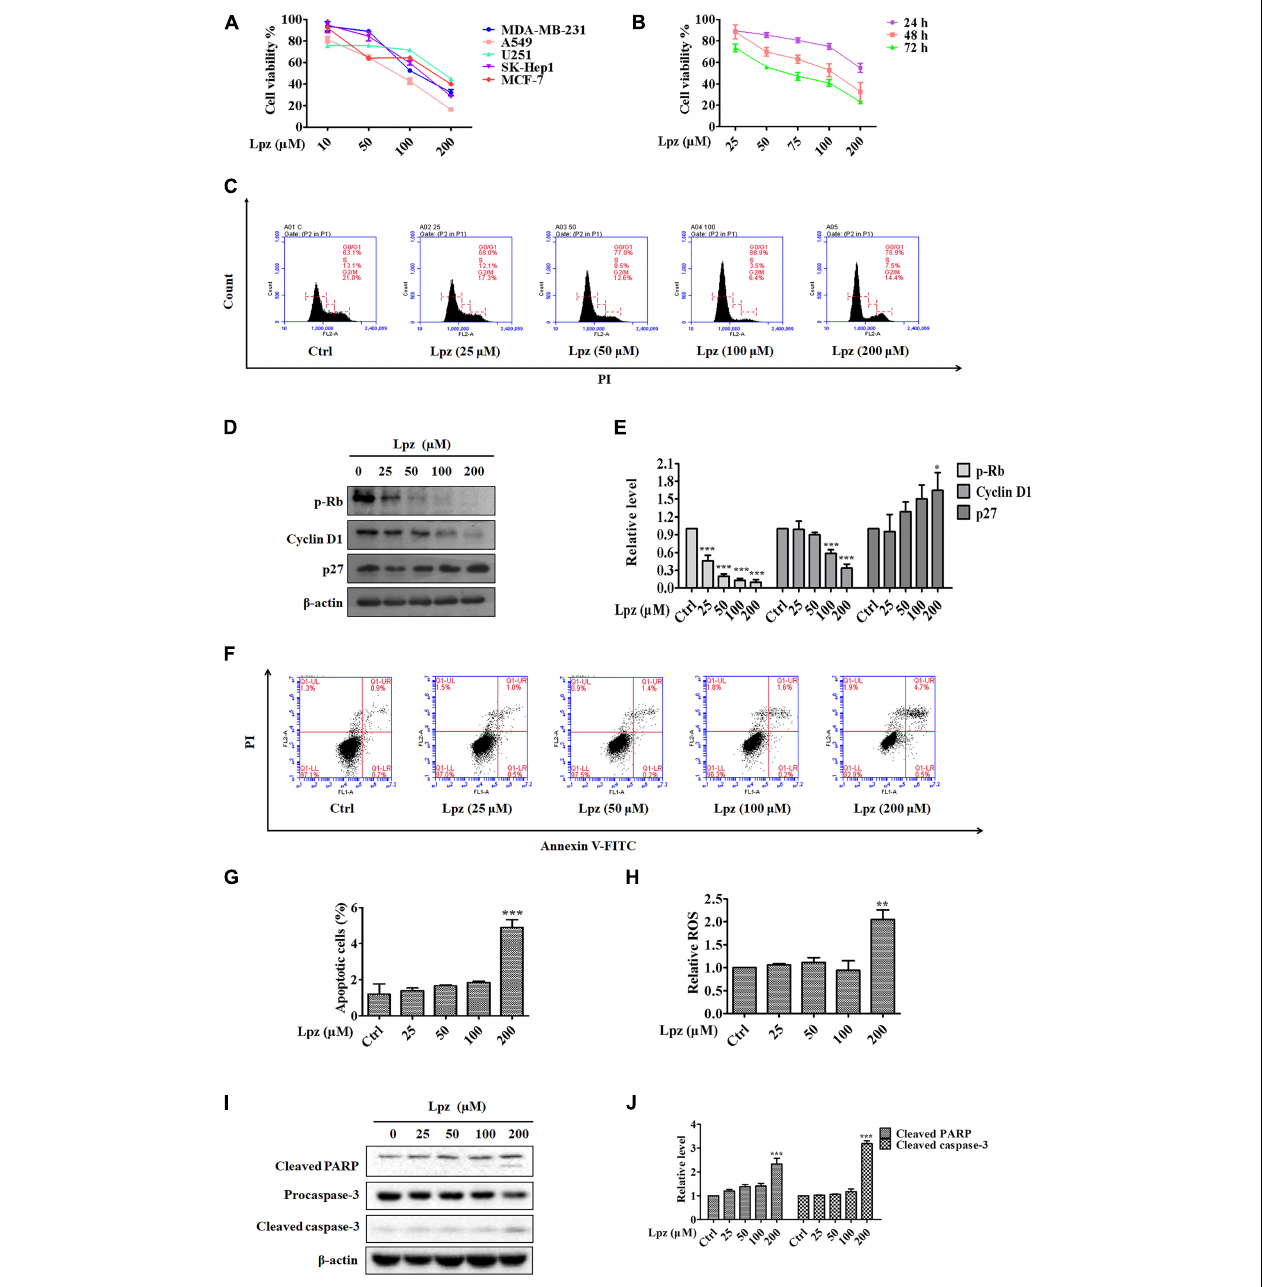
FIGURE 1 | The antitumor effect of Lpz in A549 cells. (A) The antiproliferative effect of Lpz on a variety of cancer cells after 48 h. (B) Lpz inhibited A549 cell proliferation in a time- and concentration-dependent manner. (C) Lpz induced cell cycle arrest at G0/G1phase. (D) Effect of Lpz on G0/G1 cell cycle-related proteins. (E) Quantification of the results in panel (D) . (F) Lpz induced apoptosis in A549 cells. (G) The population analysis of the apoptotic cells. (H) Lpz enhanced intracellular ROS generation. (I) Lpz increased the levels of cleaved PARP and caspase-3. (J) Quantification of the results in panel (I) . Data shown are the mean ± SD of three independent experiments. *: p < 0.05, **: p < 0.01, and ***: p < 0.001.